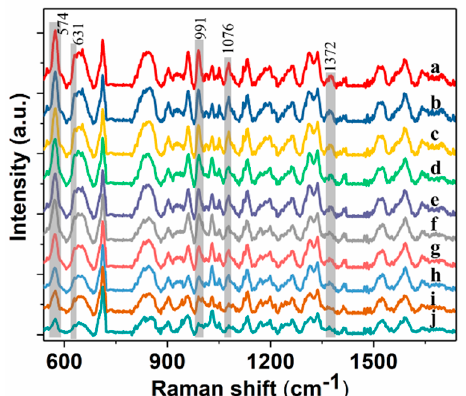
Figure 6. Spectra of pirimiphos-methyl residues in the wheat samples of 23.93, 15.85, 11.72, 9.05, 7.36, 4.75, 3.49, 1.45, 0.91 and 0.25 mg / L ( a – j ) with the proposed extraction method.